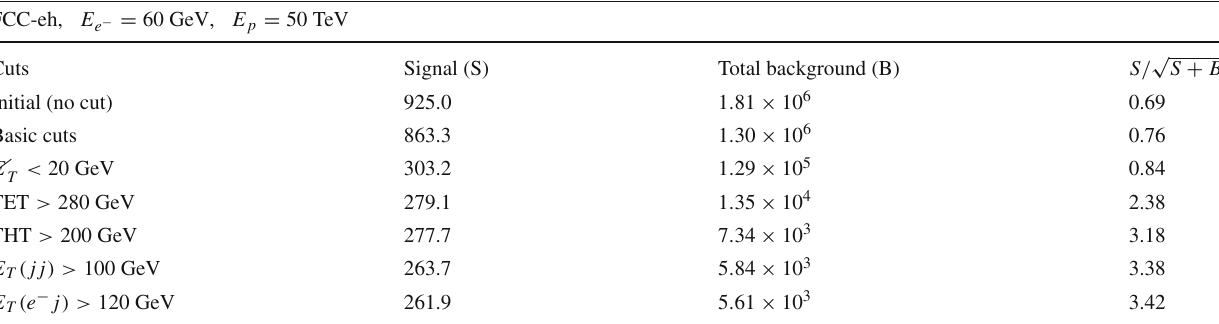
Table 4 Effect of individual kinematical cuts on the signal-1 for M h backgrounds at the FCC-eh. The statistical significance SS is computed for an integrated luminosity of 1 ab − 1 FCC-eh, E e − = 60 GeV, E p = 50